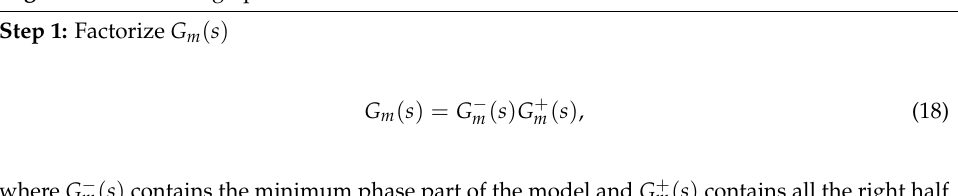
Algorithm 2 The design process of the IMCPID